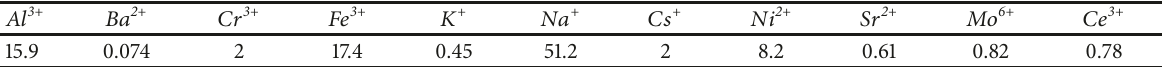
Table 2: Composition of typical power nuclear reactor aqueous HLW (g/L) [28].